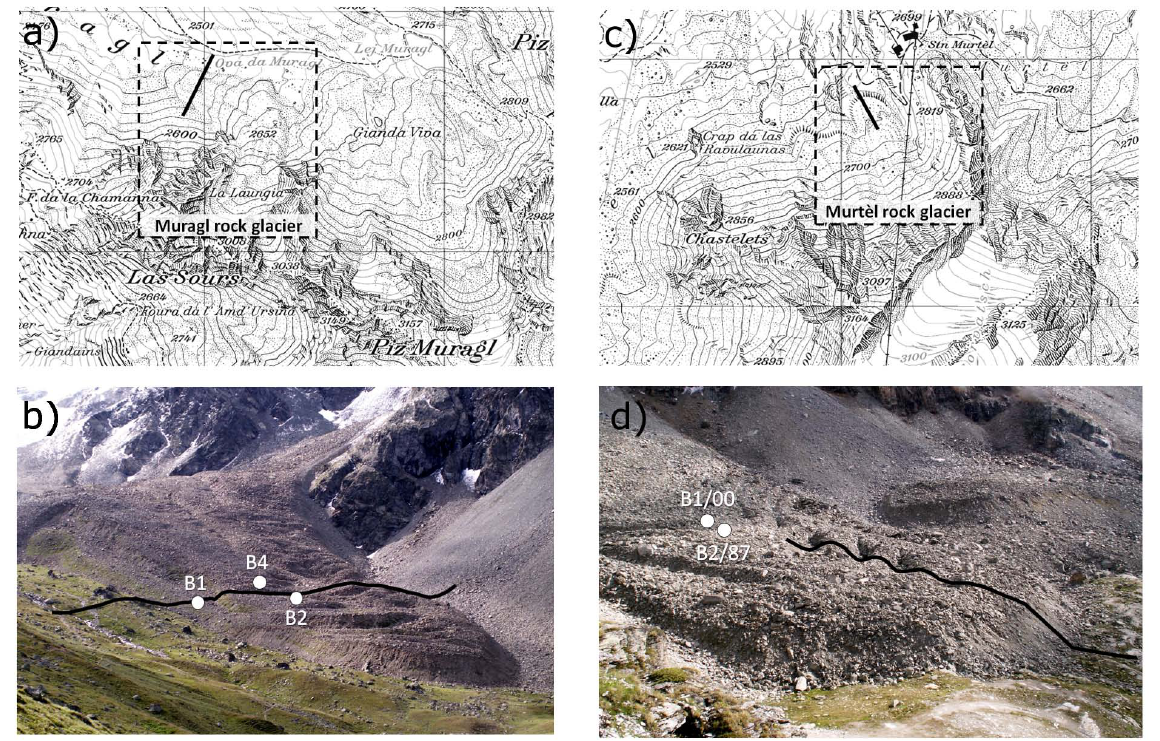
Fig. 5. Topographical map of the study areas (source: swisstopo) and photographs with borehole locations and survey lines for (a–b) Muragl rock glacier and (c–d) Murt`el rock glacier. Photos by C.